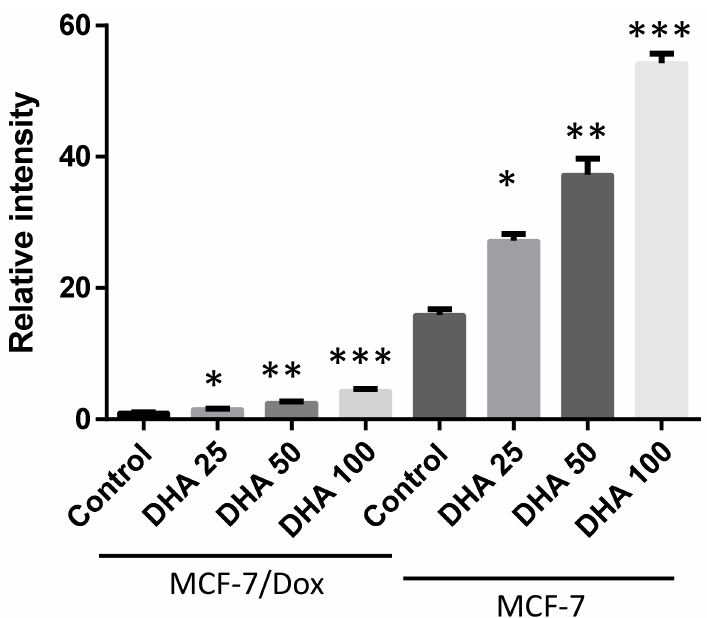
Figure 2. Effect of DHA on doxorubicin accumulation in doxorubicin-resistant and parental MCF-7 cells. Both Doxorubicin-resistant MCF-7/Dox cells and the parental Doxorubicin-sensitive MCF-7 cells were treated with various concentrations of DHA overnight, followed by treatment with 2 µ M of doxorubicin for 1 h at 37 ◦ C. After washing, cells were lysed using a lysis buffer, and fluorescence intensity was measured using a Perkin Elmer LS-50B spectrometer with an excitation wavelength of 470 nm and emission wavelength of 595 nm. The values presented are the mean ± standard error of the mean, based on three independent experiments. A p -Value of <0.05 is considered significant by a Newman–Keuls one-way ANOVA with multiple comparisons test. * p < 0.05, ** p < 0.01, *** p < 0.001 compared to respective untreated